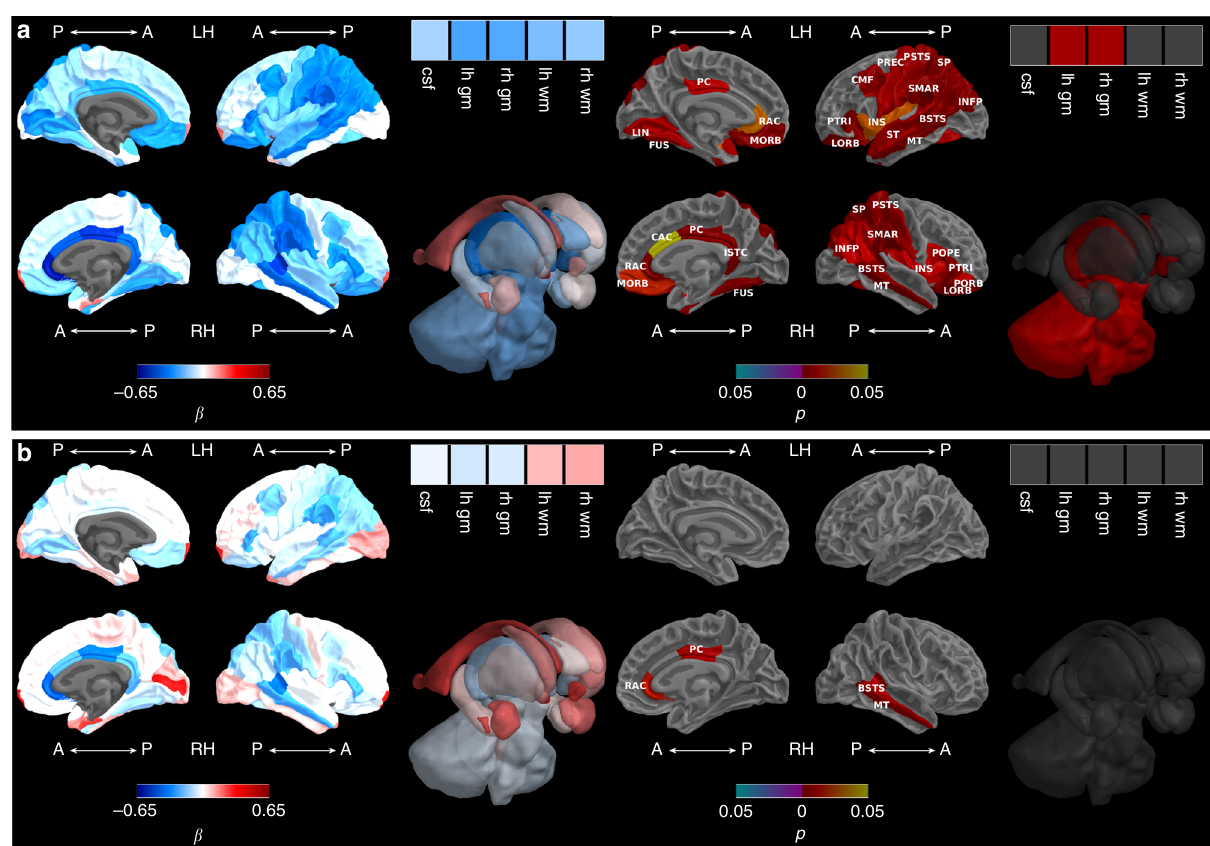
Fig. 1 Very preterm versus full-term brain growth from term-equivalent to 7 years. a Before and b after adjusting for total brain tissue volume. Note: Group-by-time regression coef fi cients from linear mixed effects models ( β ) in blue refer to negative associations (slower growth in the very preterm compared with the full-term group) and in red refer to positive associations (faster growth in the very preterm compared with the full-term group), with darker coloured regression coef fi cients indicating stronger associations; Interaction p values are false discovery rate corrected and darker coloured p values indicate stronger signi fi cance; Boxes in the top right corner of the fi gures represent global brain volumes. A = anterior, P = posterior, LH = left hemisphere, RH = right hemisphere, csf = cerebrospinal fl uid, gm = grey matter, wm = white matter, BSTS = banks of superior temporal sulcus, CAC = caudal anterior cingulate, CMF = caudal middle frontal, FUS = fusiform, INFP = inferior parietal, INS = insula, ISTC = isthmus cingulate, LORB = lateral orbitofrontal, LIN = lingual, MORB = medial orbitofrontal, MT = middle temporal, POPE = pars opercularis, PORB = pars orbitalis, PTRI = pars triangularis, PSTS = postcentral, PC = posterior cingulate, PREC = precentral, RAC = rostral anterior cingulate, SP = superior parietal, ST = superior temporal, SMAR =